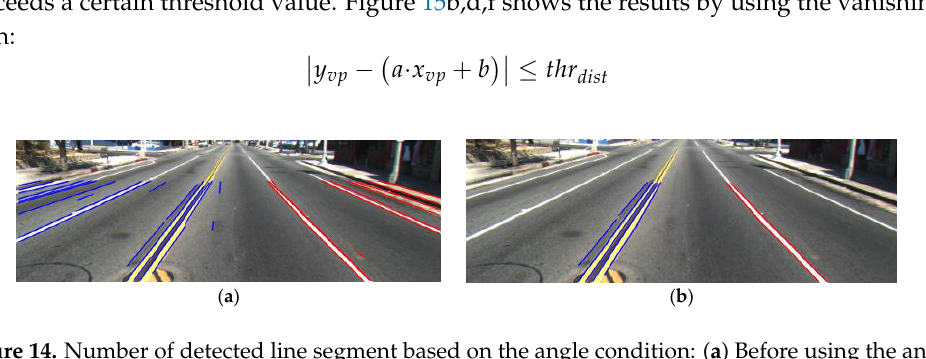
Figure 14. Number of detected line segment based on the angle condition: ( a ) Before using the angle condition; ( b ) After using the angle condition.